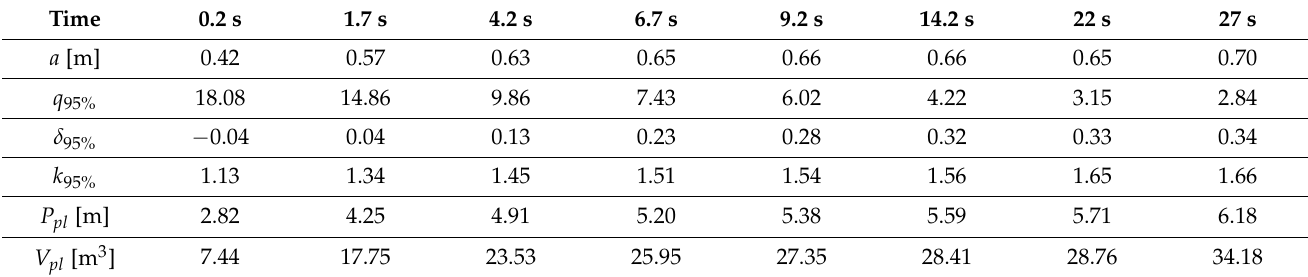
( b ) Figure 6. Time evolution of voltages for the DTT flat-top phase: ( a ) CS voltages; ( b ) PF voltages. Table 5. Time evolution of CS/PF currents of the SN flat-top phase. Time